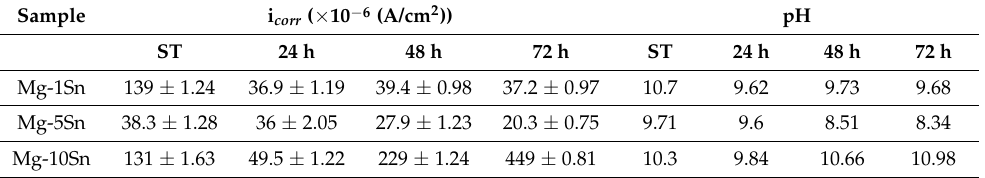
Table 2. Corrosion results of Mg-Sn alloys estimated by Tafel extrapolation